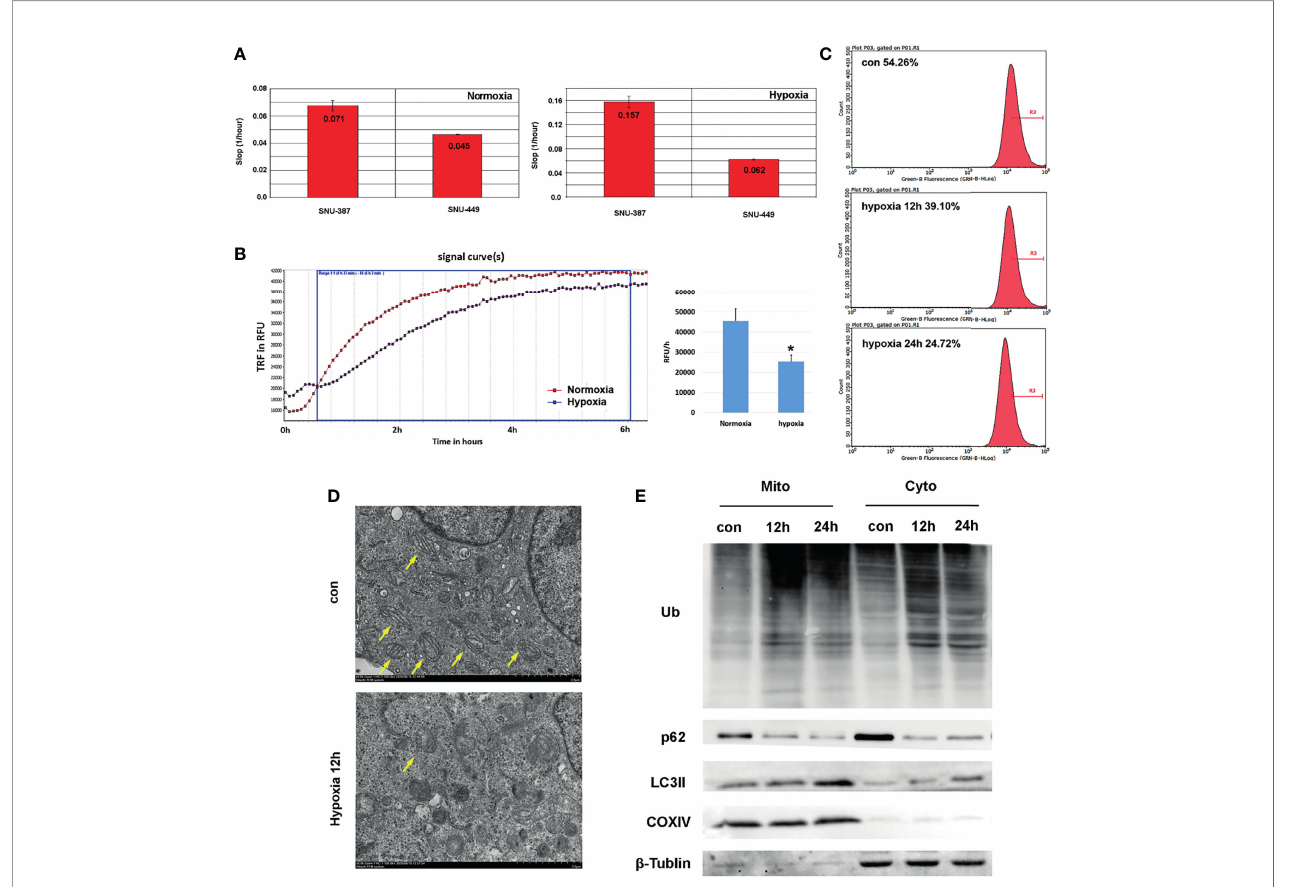
FIGURE 1 | Hypoxia suppressed mitochondrial function and promoted mitophagy of HCC cells. (A) Cell proliferation rate was measured by RTCA system and the increasing slop was used for cell growth rate detection. (B) Measurement of OCR in SNU-387 cells exposed to hypoxia or normoxia for 6h (means ± SD, n = 3, * P < 0.05). (C) Mitochondrial mass was analysis by mito-tracker green in SNU-449 cells under hypoxia. (D) The morphology of SUN-387 cells mitochondria was observed with TEM under hypoxia. (E) Mitochondria of SNU-387 cells was isolated and the protein expression of autophagy were